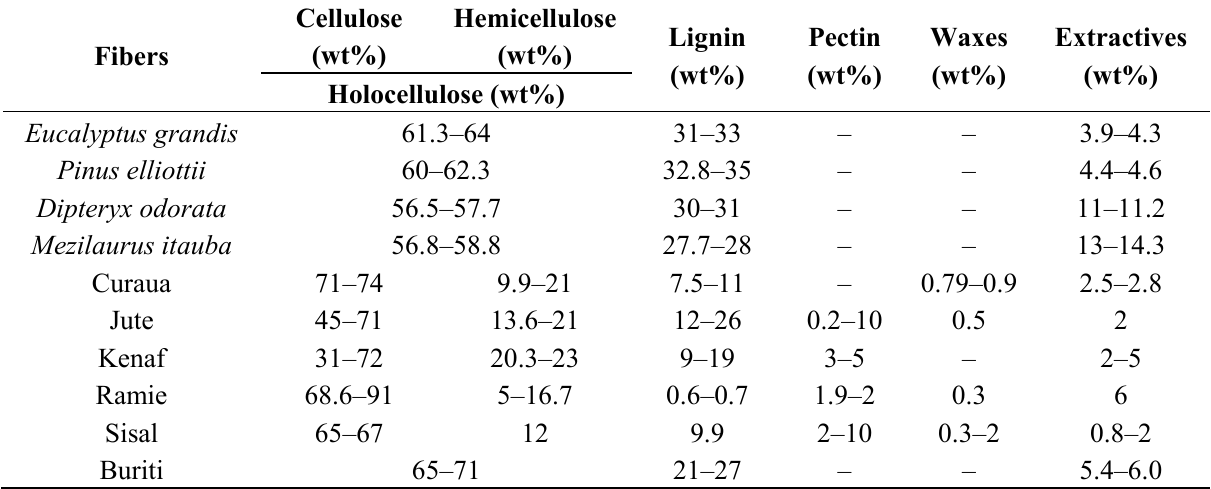
Table 1. Chemical composition of the fibers used in this study obtained from the literature [11–14].